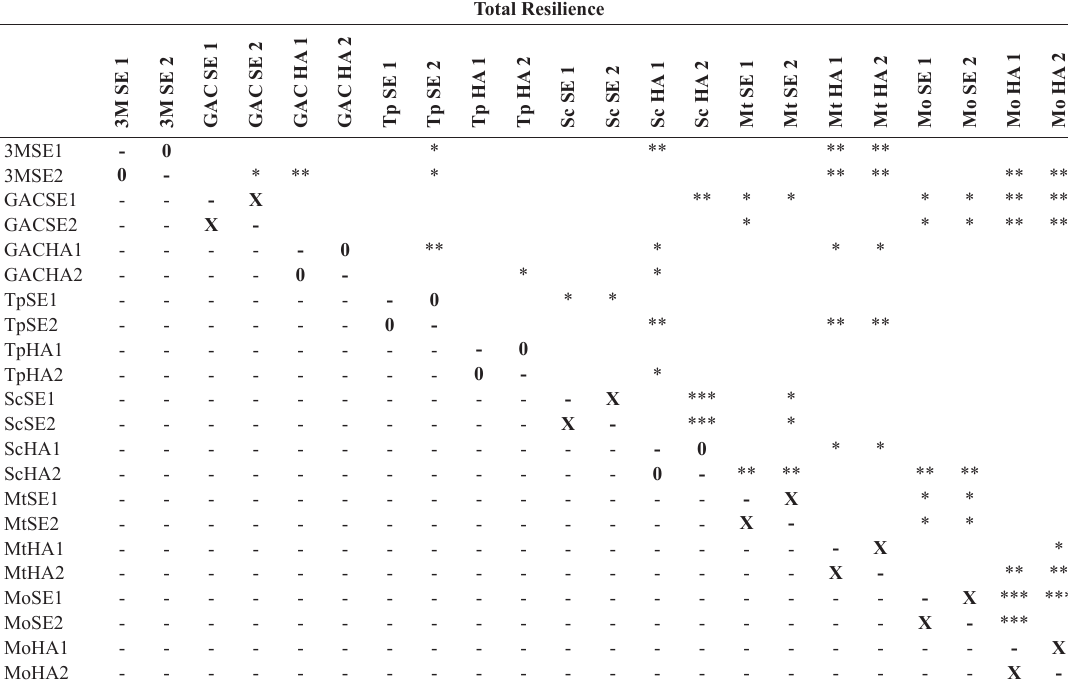
Table 6. Total resilience comparison among different groups and commercial lots by Tukey test